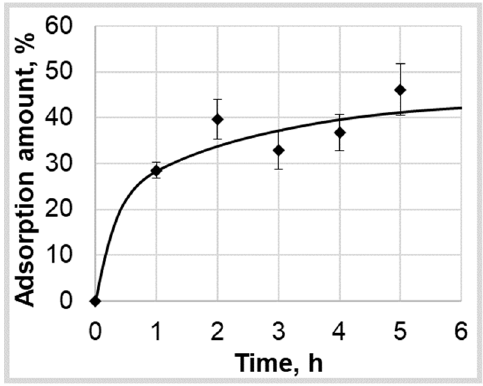
Figure 8. Experimental ( (cid:117) ) and calculated ( − ) data of ibuprofen supercritical adsorption into silica aerogel kinetics at pressure 140 bar and temperature 323 K.